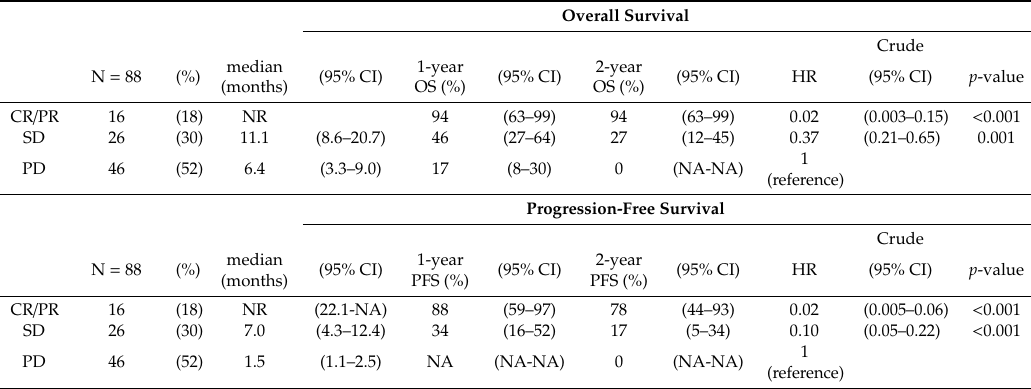
Figure 2. Kaplan–Meier survival curves of each best overall response for OS ( a ) and PFS ( b ). A higher magnitude of best overall response was significantly associated with longer ( a ) OS and ( b ) PFS (both, p < 0.001). Table 5. Relationship between best overall response and